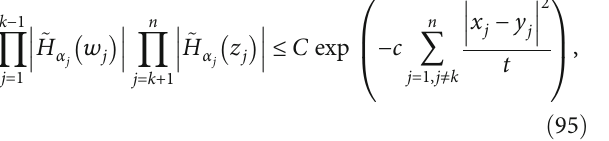
ffiffiffiffiffiffiffiffiffiffiffiffi